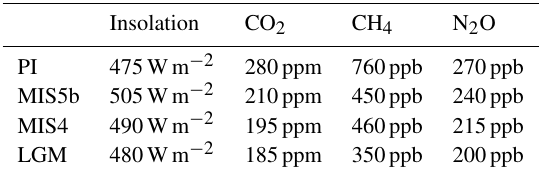
Table 1. Top of the atmosphere insolation during the northern sum- mer solstice (60 ◦ N; Berger and Loutre, 1991) and greenhouse gas concentrations (Petit et al., 1999; Spahni et al., 2005) in the time slice